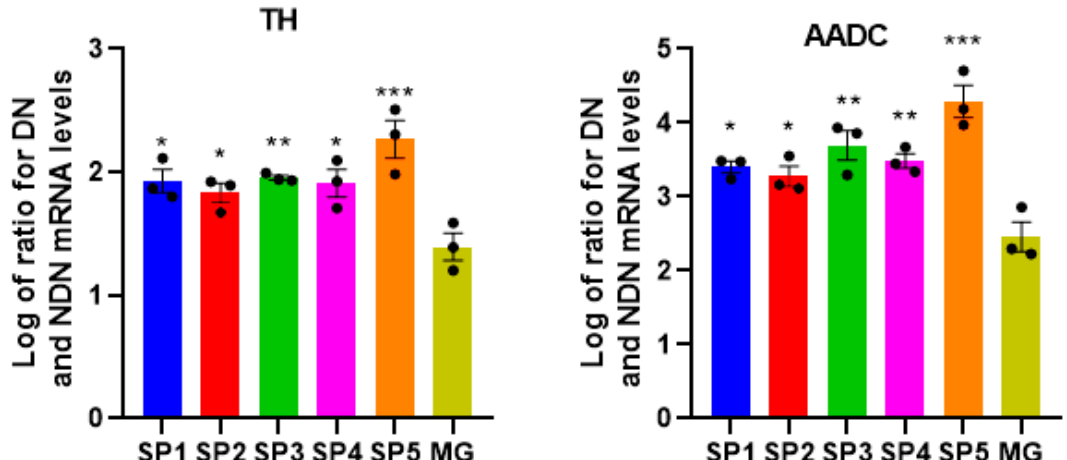
Figure 6. Ratios of the mRNA levels for TH and AADC between DN and NDN when NPCs were cultivated on different coatings. Individual repeat values in the histogram are indicated by black dots. Mean ± SEM, N = 3–6. One-way ANOVA followed by Dunnett’s post hoc test. * p ≤ 0.05, ** p ≤ 0.01, *** p ≤ 0.001 compared with MG.